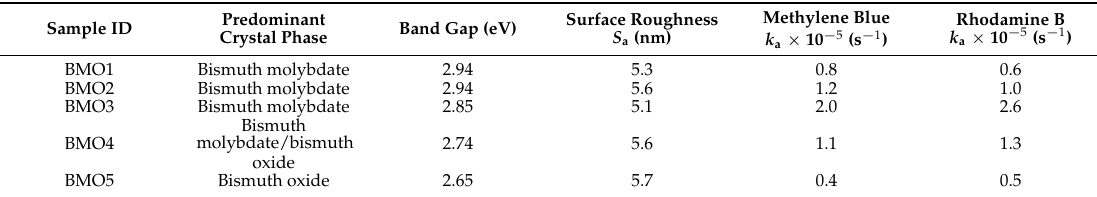
Table 2. Band gap and surface roughness values and dye degradation rate constants for bismuth molybdate coatings.